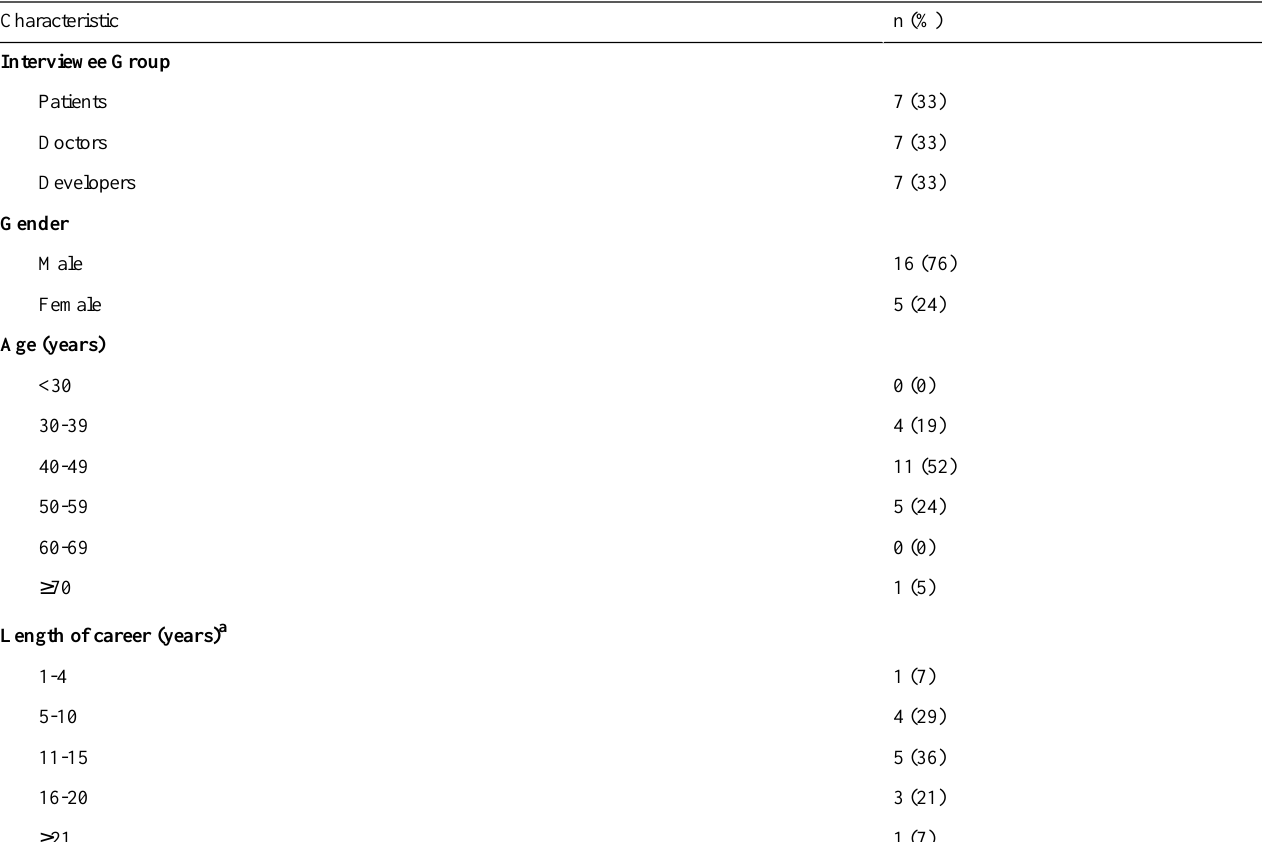
Table 1. Demographic characteristics of participants